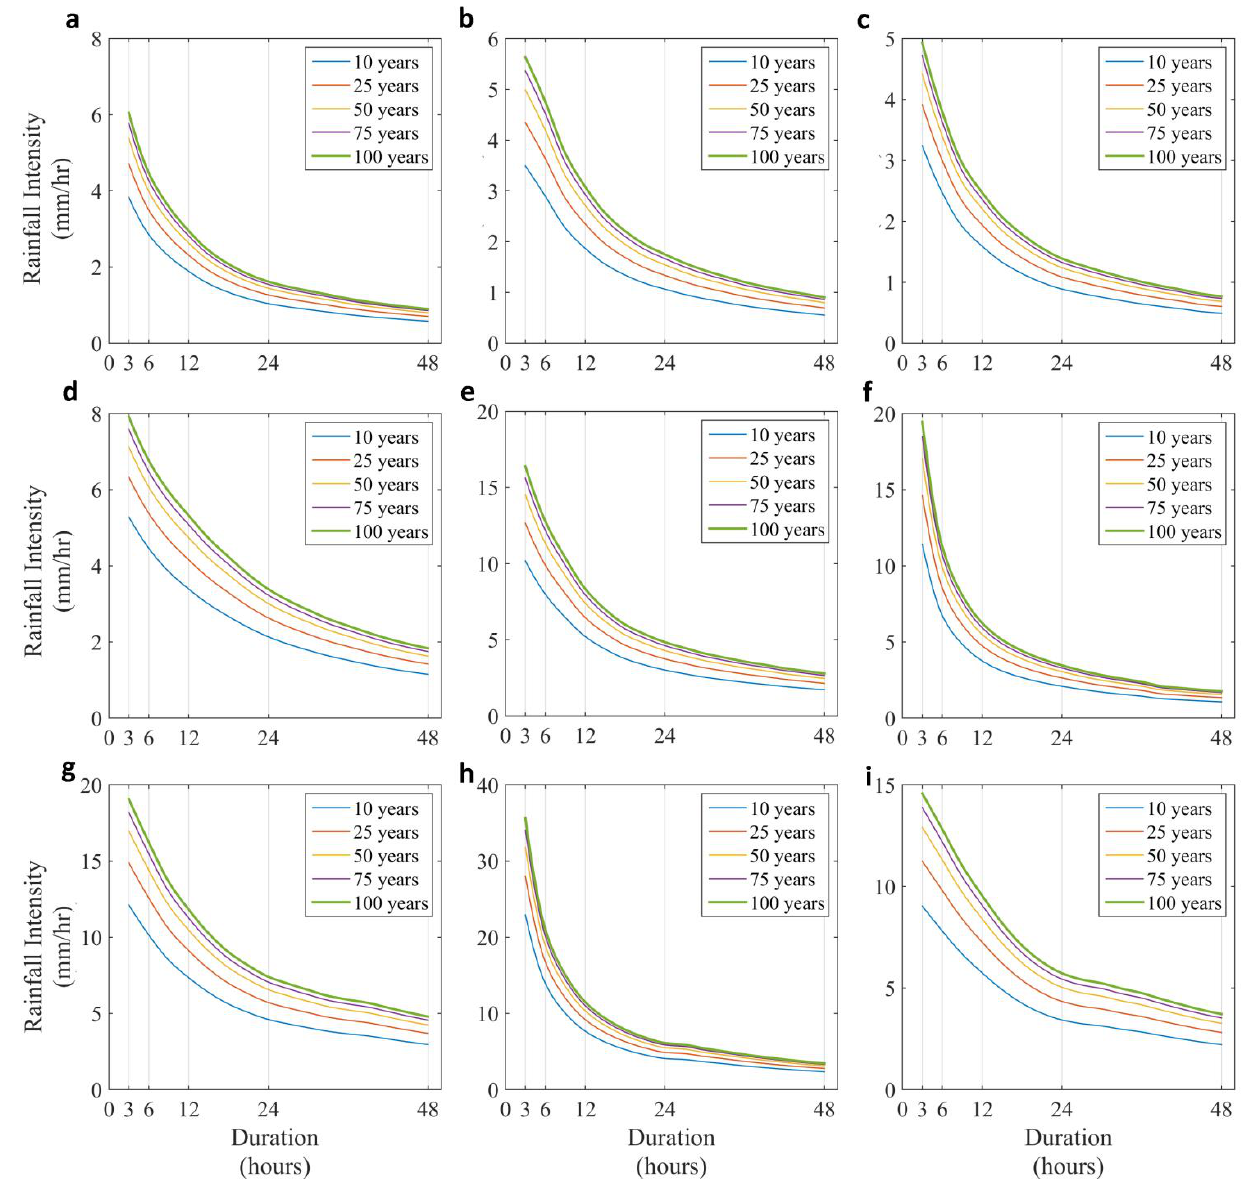
Figure 13. IDF curves (modeled output) for selected locations/cities in the west part of the Arabian Peninsula: ( a ) Arar, ( b ) Tabuk, ( c ) Hail, ( d ) Medina, ( e ) Jeddah, ( f ) Mecca, ( g ) Jazan, ( h ) Sanaa and ( i ) Aden.